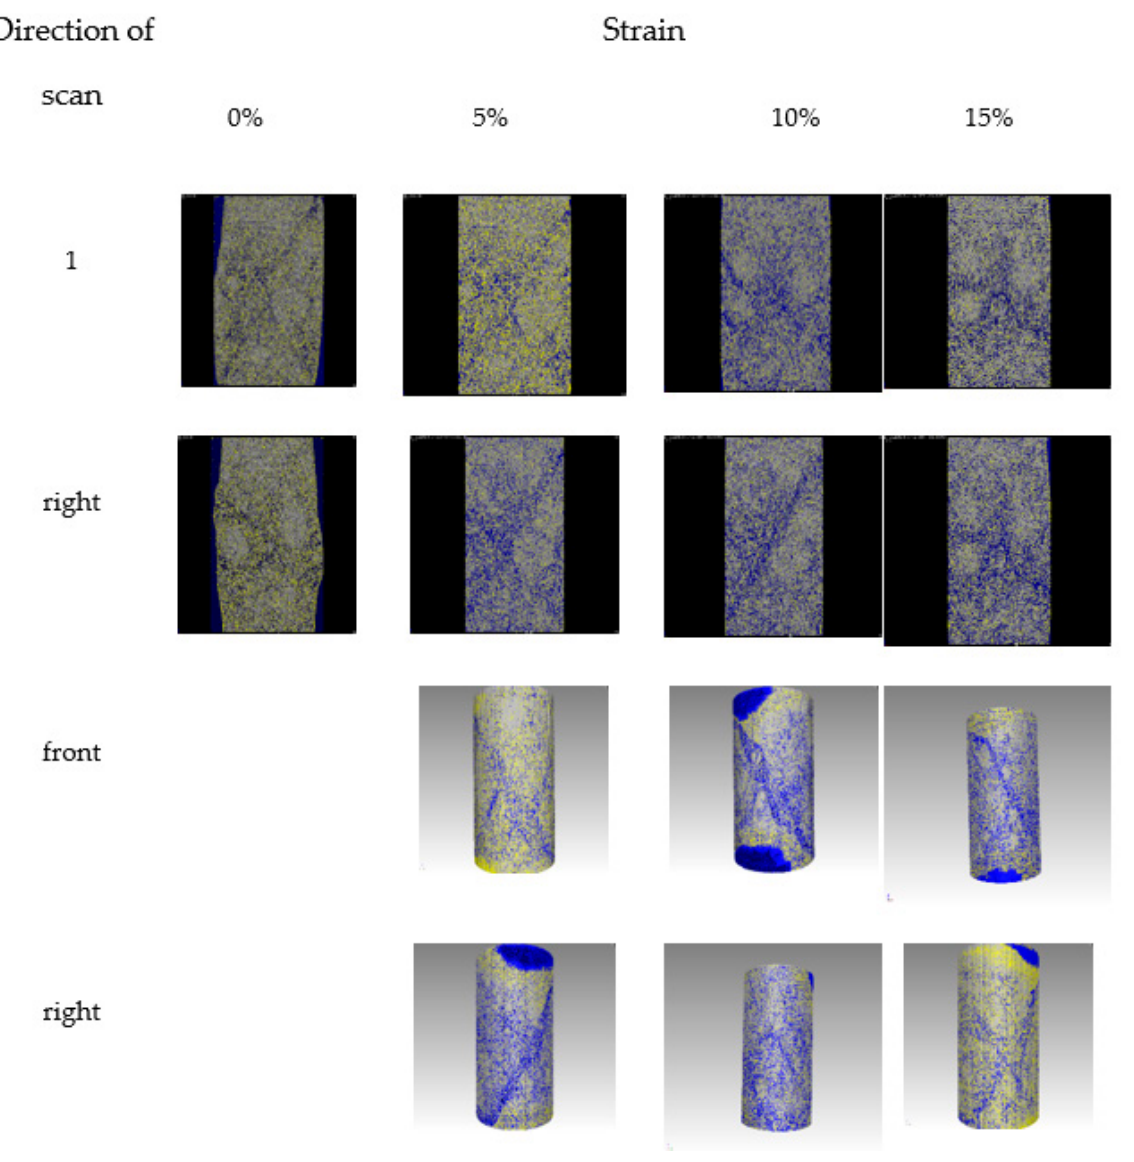
Figure 8. CT images with strain in different scanning directions (S h = 25%). ‘front’/’right’ and ‘1’ mean the different directions of CT scan to the samples. The color of white indicates sand; the yellow indicates hydrate; the blue indicates